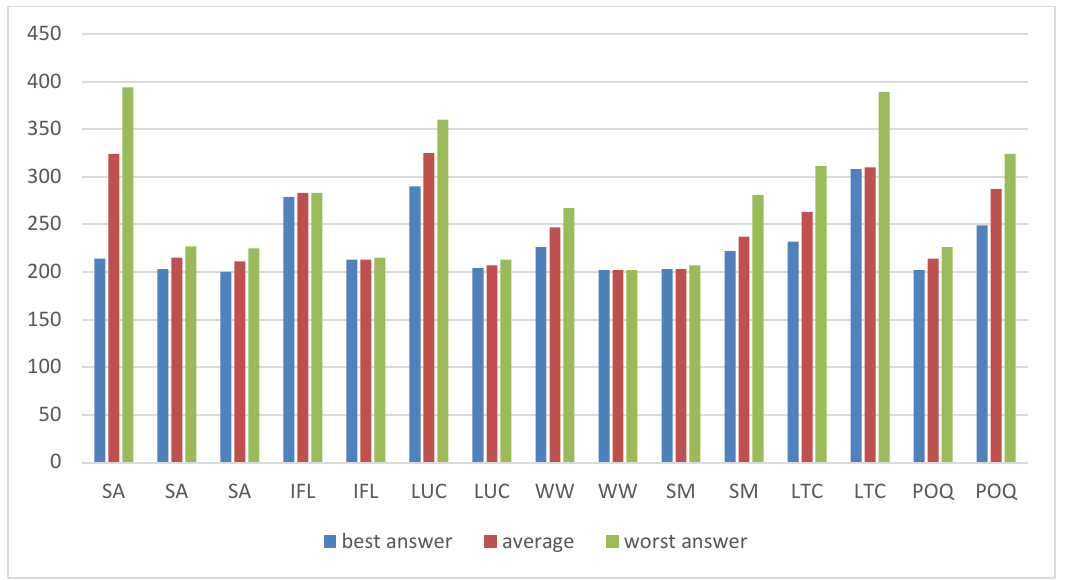
Fig. 3. The comparison chart for 30